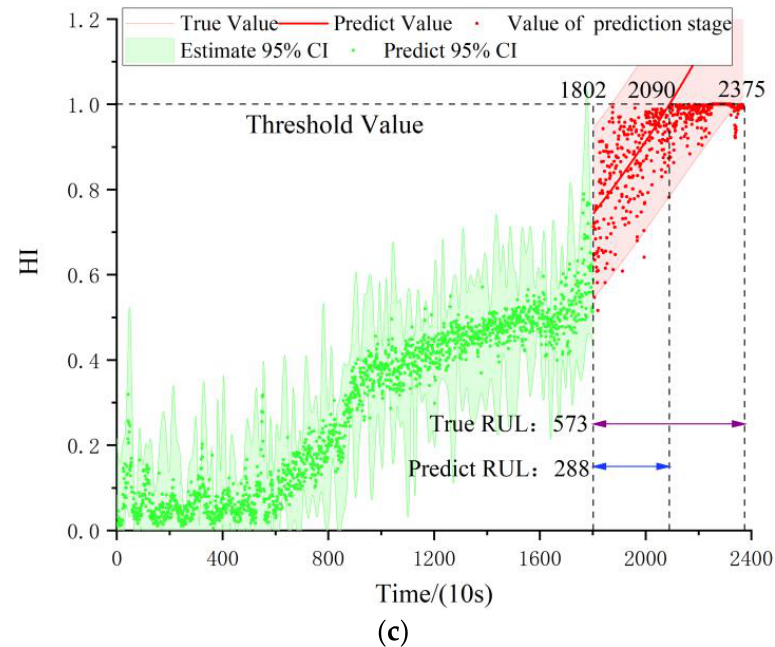
Figure 14. RUL results of Bearing1_3. ( a ) Remaining useful life prediction results based on the model presented in this paper, ( b ) remaining useful life prediction results based on the LSTM model, ( c ) remaining useful life prediction results based on the CNN mode.